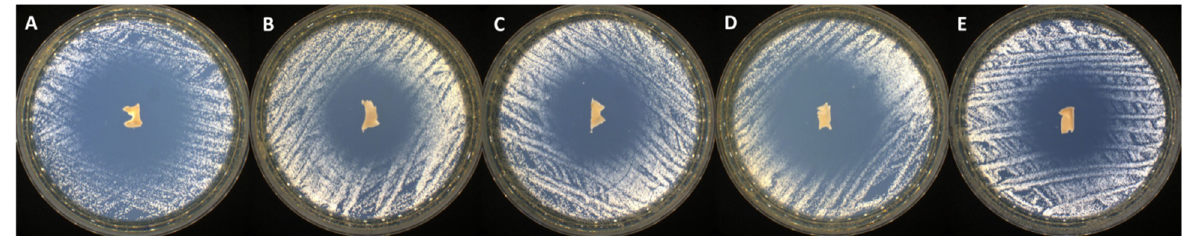
Figure 6. Antifungal activity of the tested samples: ( A ) PVA_PEBSA 25/75 _Thy_ α -Tcp, ( B ) PVA_PEBSA 50/50 _Thy_ α -Tcp, ( C ) PVA_PEBSA 75/25 _Thy_ α -Tcp, ( D ) PVA_PEBSA 50/50 _2xThy_ α -Tcp, and ( E ) PVA_PEBSA 50/50 _Thy_2x α -Tcp against C. albicans .